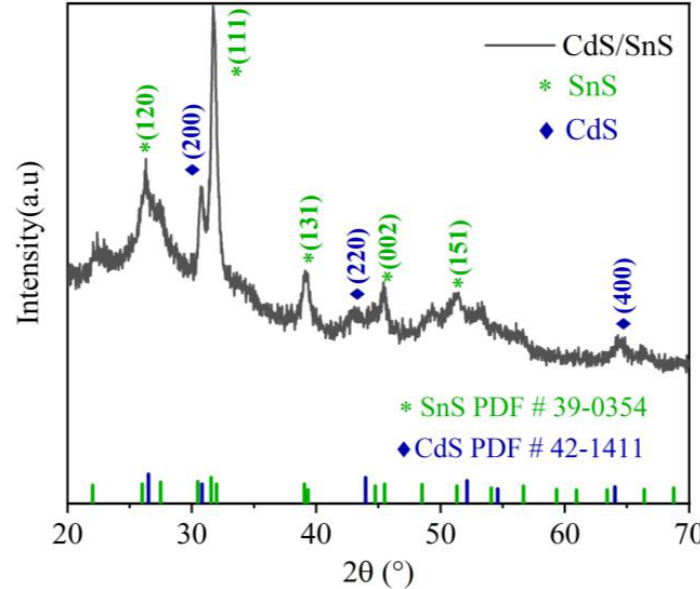
Figure 4. XRD patterns of pure CdS, SnS and CdS/SnS.